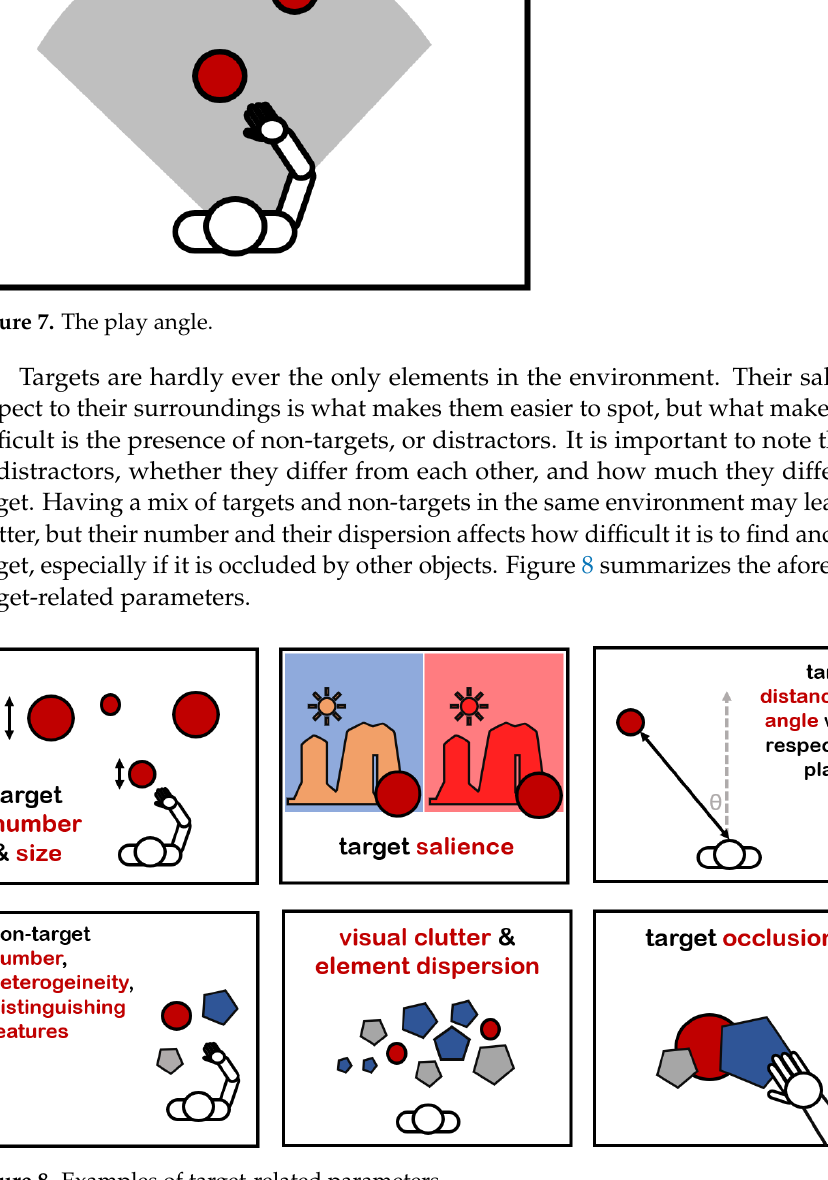
Figure 8. Examples of target-related